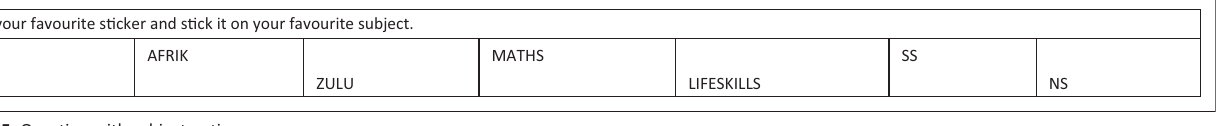
FIGURE 5: Question with subject options.